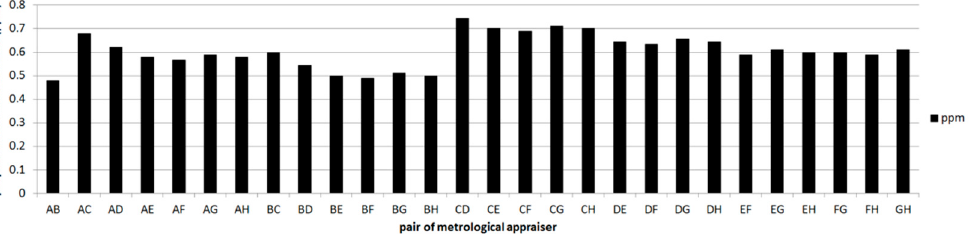
Figure 4. Proportion of nonconforming shafts calculated from data measured by pairs of metrological appraisers.